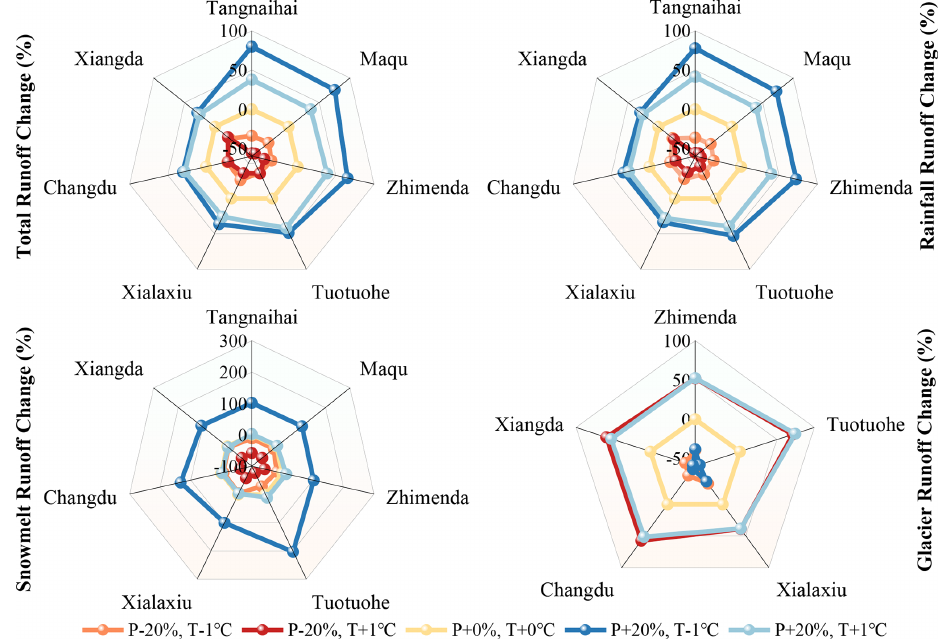
Figure 8. Percentage changes in mean annual total, rainfall, snowmelt, and glacier runoff relative to the period 1984–2018 under four climate change combination scenarios for the seven